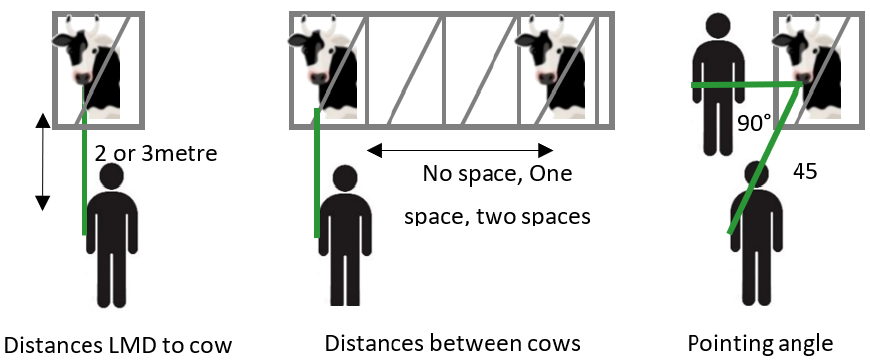
Figure 1. The measurement combinations that were applied during the systematic validation of measuring assumptions of the LMD as applied in dairy cattle.